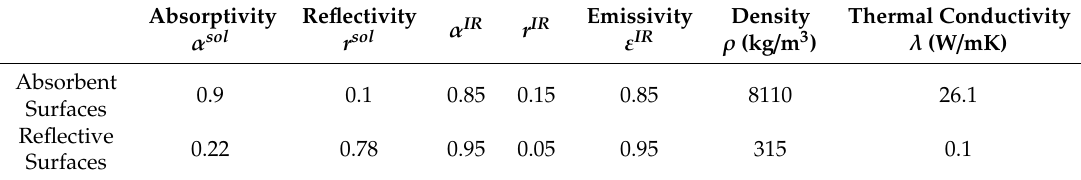
Table 1. Properties of materials used, from literature data [35–39].